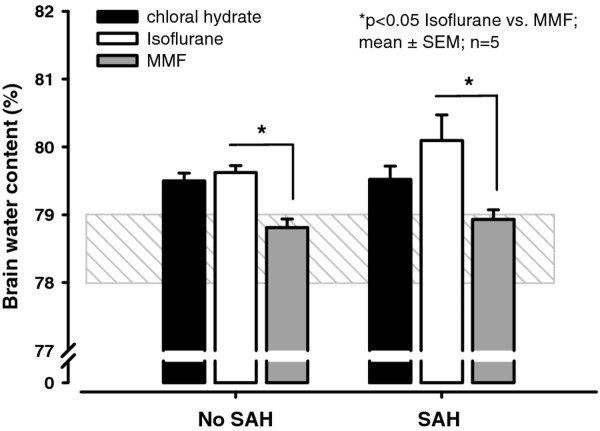
Brain water content (BWC) 3 hours following SAH or in respective control animals. Streaked gray area indicates the range of normal brain water content in animals not subjected to long-term anesthesia. BWC is within the normal range under MMF anesthesia while it is elevated in rats anesthetized with isoflurane (p < 0.05) or chloral hydrate (Control). Following SAH BWC increased only in animals anesthetized with isoflurane while it remained unchanged in animals receiving chloral hydrate or MMF. Values are presented as mean ± SEM for n = 5 in each group, *p < 0.05 vs. isoflurane (Kruskal-Wallis ANOVA on ranks followed by Dunn's Method).